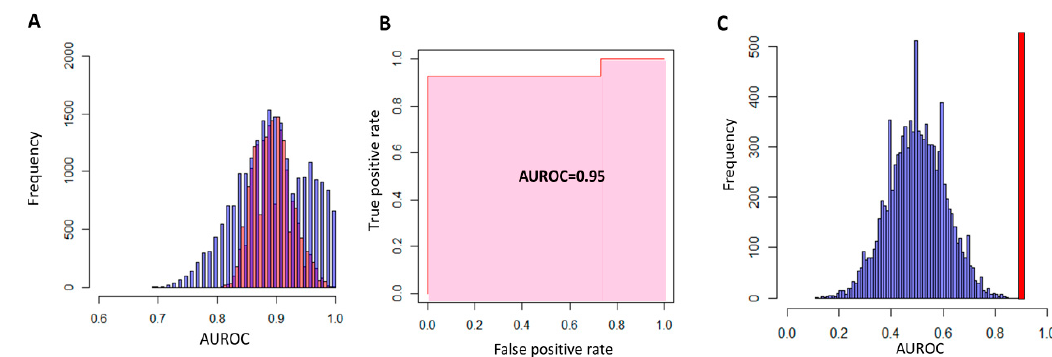
Figure 3. Performances of the LR models in the training-validation sets ( A ) and the test set ( B and C ). After LASSO, LR models with downregulation or stimulation protocol and MCP-1 as predictor variables were built and applied to the training and the validation sets. Histograms of AUROC show, as expected, good predictive performance of this models on the training set (red bars in A ). Median AUROC in the validation sets was similar to the one found with the training set (~ 0.90) but exhibited more dispersion (blue bars in A ). When the response vector in the test set was permuted, the performance of the model was indistinguishable from that of the random model (median and mean AUROC equal to 0.5, blue bars in C ) and very different for the predictive capability of the model on the original response vector (AUROC = 0.95, red bar in C ).